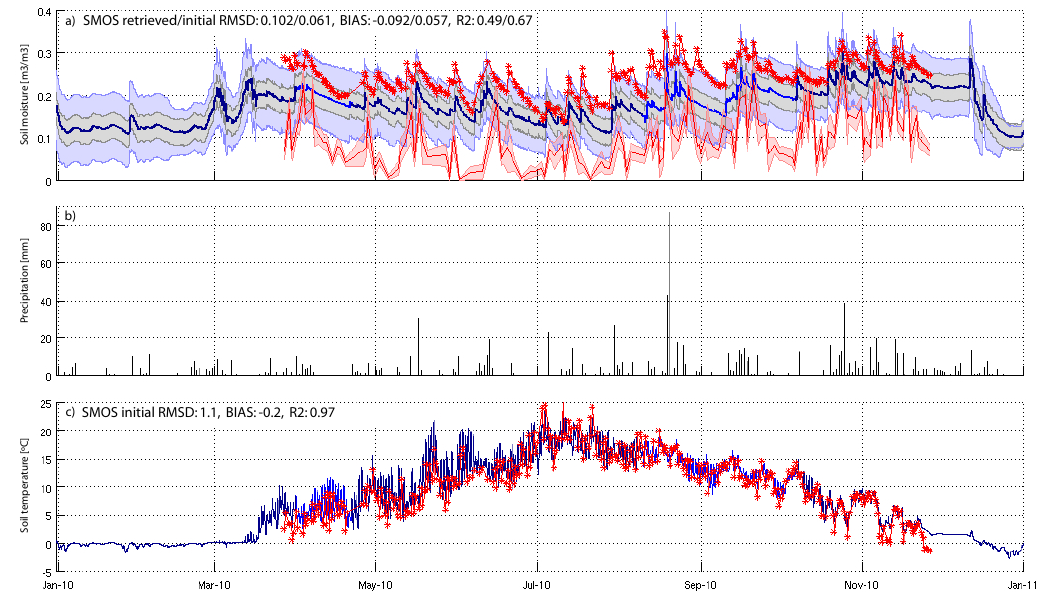
Fig. 11. Surface soil moisture and temperature (0–5cm) comparison between network and SMOS for the year 2010: (a) surface soil moisture network average and standard deviation (blue lines* and shaded region) including sensor accuracy (grey-shaded region), and retrieved SMOS soil moisture (red line) including the associated retrieval error estimate (DQX, red-shaded region) and corresponding initial guess (red stars); (b) mean of daily precipitation of the DMI 10 km grid nodes contained within the SMOS pixel; (c) surface soil temperature network average (blue lines) and SMOS initial guess (red stars). RMSD, bias and R 2 of the in situ versus retrieved/initial SMOS data for soil moisture and temperature are